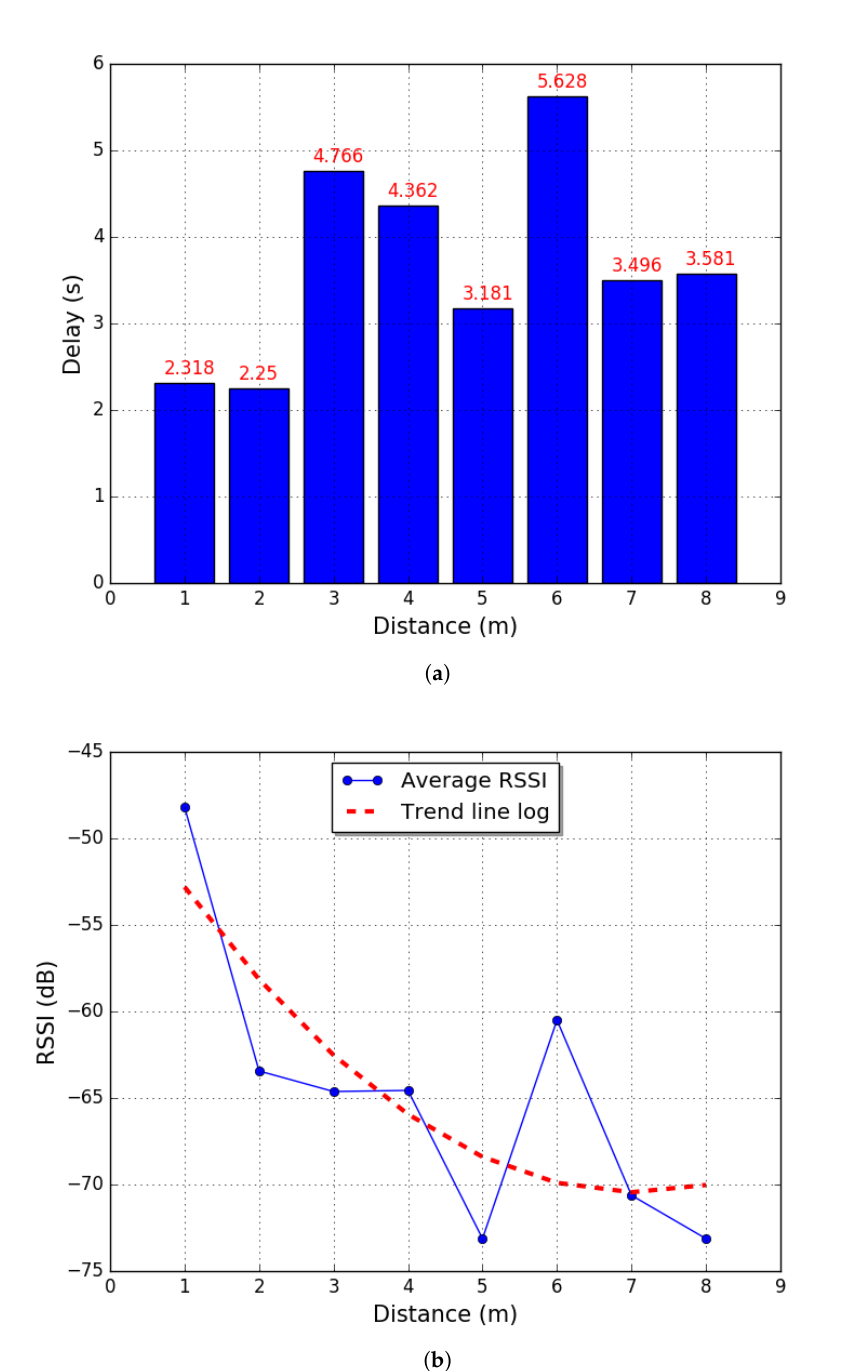
Figure 5. Wireless data transmission analysis ( a ) information transmission delay; ( b ) RSSI power level